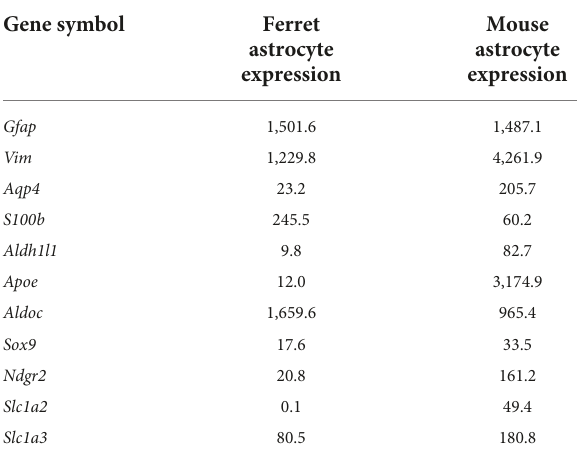
TABLE 3 Expression levels of astrocyte-specific marker genes (FPKM) in ferret and mouse astrocytes. Astrocyte-specific markers